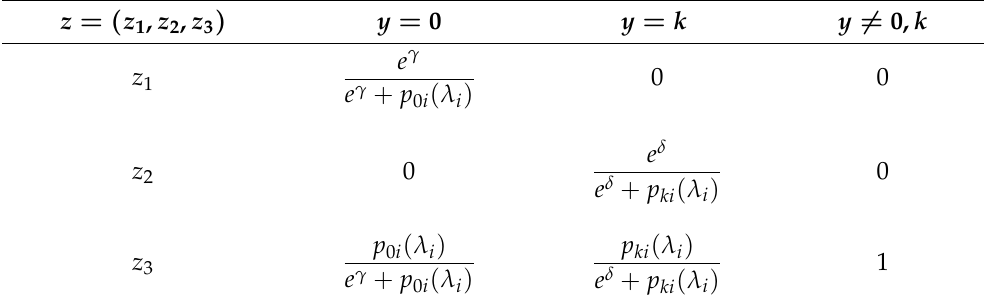
Table 2. E ( z | y ) for the ZkIP regression